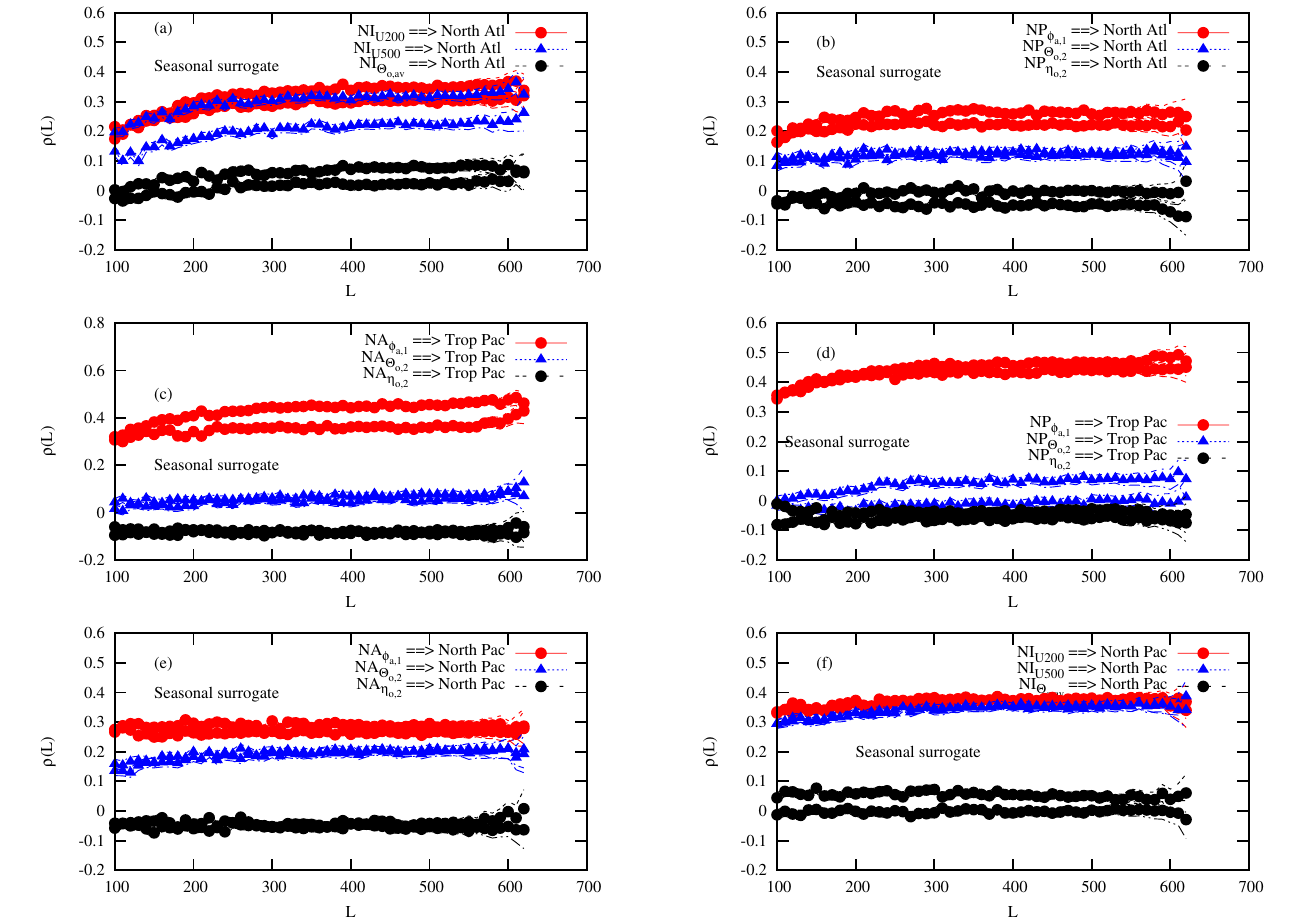
Figure 5. CCM as a function of the length L of the samples, as obtained from surrogate three-dimensional attractors built by superimposing random anomalies to the annual climatological cycle, based on the data from ERA-20C and ORA-20C reanalyses. Two different surrogates have been used. Each line with symbols corresponds to the influence of one actual variable (not a surrogate series) on a specific coupled ocean–atmosphere surrogate attractor. The specific variables are denoted in the caption corresponding to each line in each